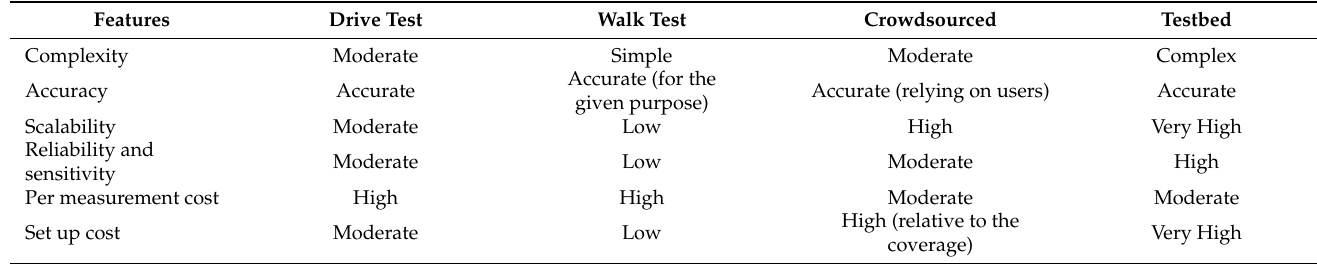
Table 9. Comparison of the different MBB measurement methods.